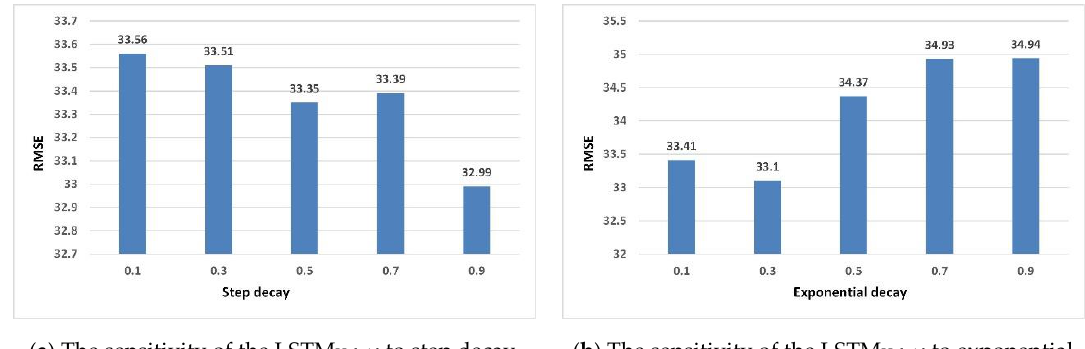
Figure 16. Performances for different learning rates of LSTM Hybrid .